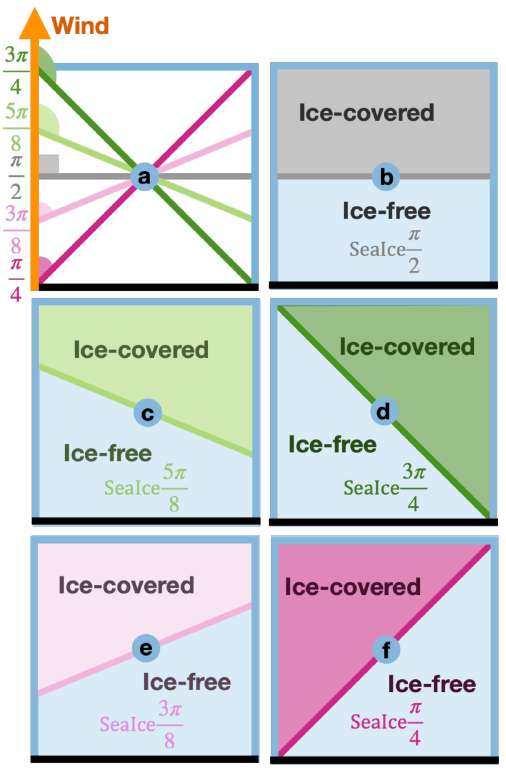
Figure 7. Ice coverages applied in this study. (a) Comparison of all ice coverages. Angles are between the ice edges (thick coloured lines) and wind direction (thick orange line). The thick black line denotes the ice shelf front. (b–f) Schematics of sea ice coverage (shaded patches) and sea ice edge (thick coloured lines), with the same colour scheme as shown in (a) . Ice-free regions are shaded in pale